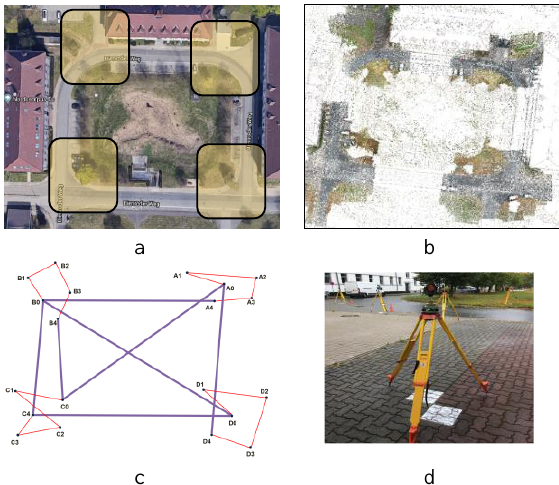
Figure 4 : Configuration of second experiment; a) Study area which captured from 55m height and 4 small areas captured from 10 m height, b) sparse point cloud of merged flights, c) check distances which are employed for analyzing the results, d) surveying setup at one of the small corner areas.